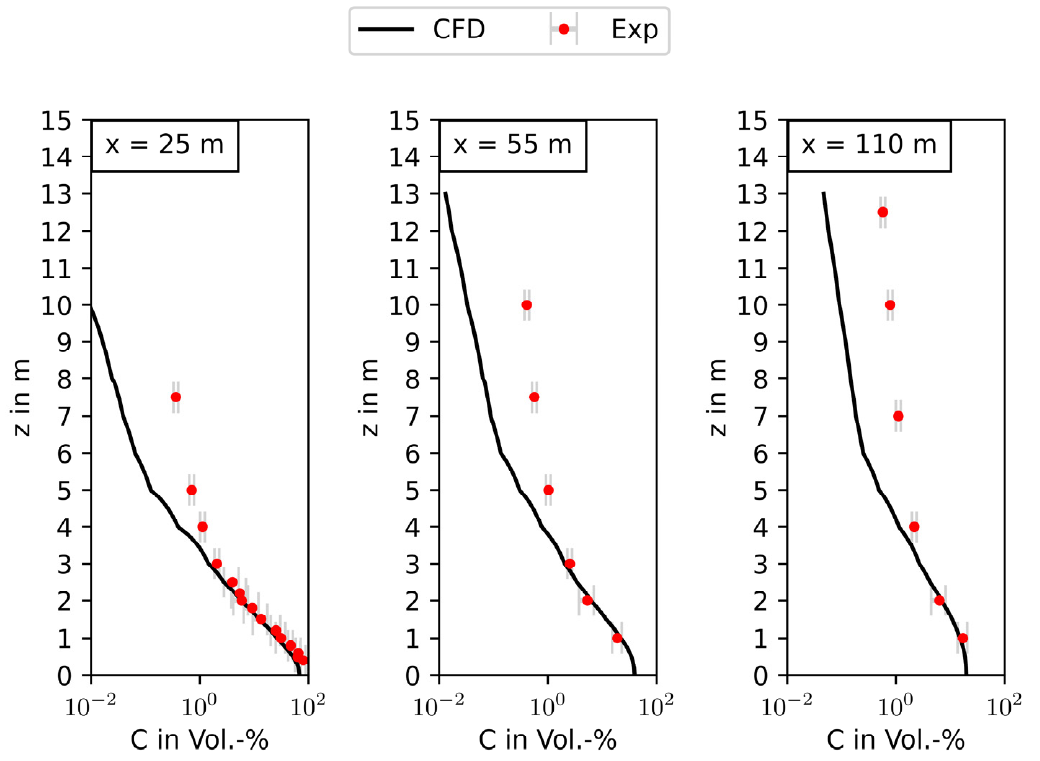
Figure 11. Vertical concentration profiles on the heavy gas cloud centerline in 25 m ( left ), 55 m ( middle ) and 110 m ( right ) to the origin, and 5 m, 35 m and 90 m to the source, respectively.